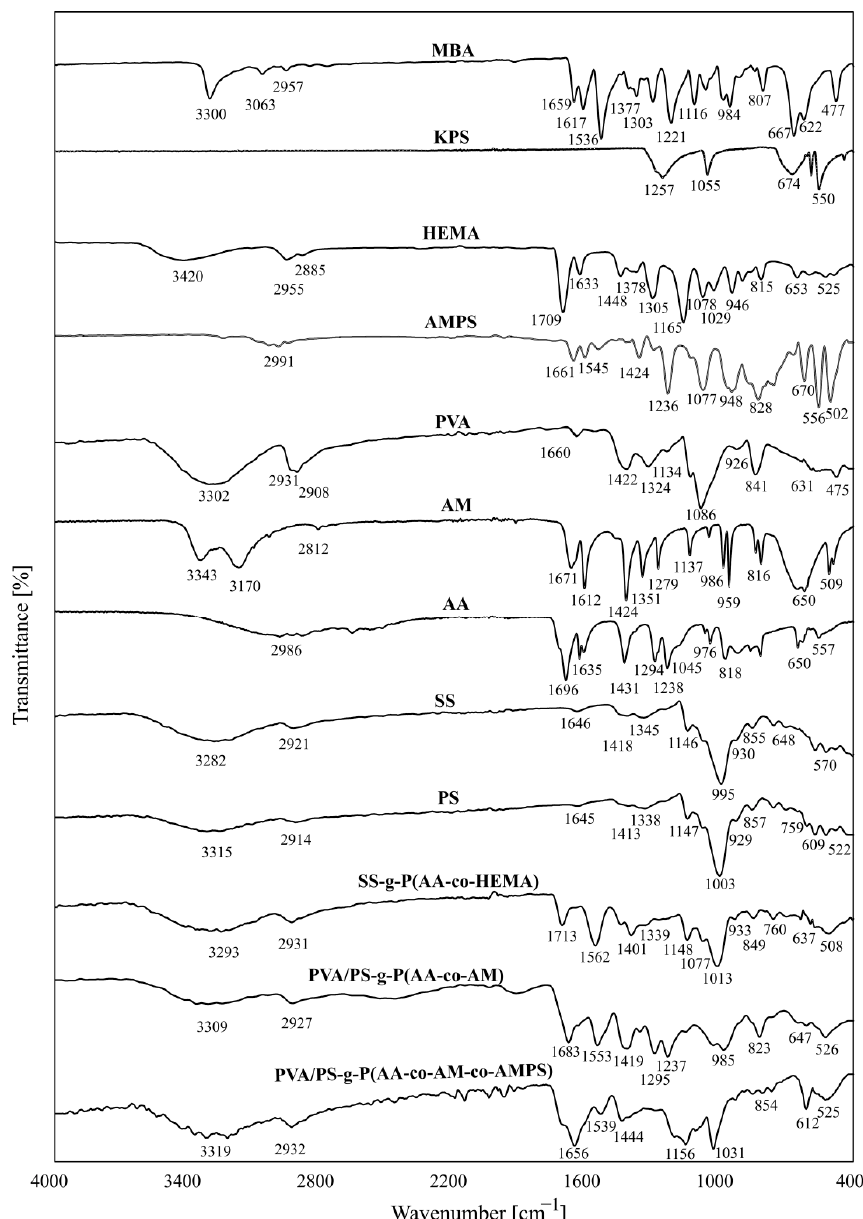
Figure 4. FTIR spectra of AMPS, PVA, AA, MBA KPS, PS, AM, PVA/PS-g-P(AA-co-AM-co-AMPS), PVA/PS-g-P(AA-co-AM) and SS-g-P(AA-co-HEMA).